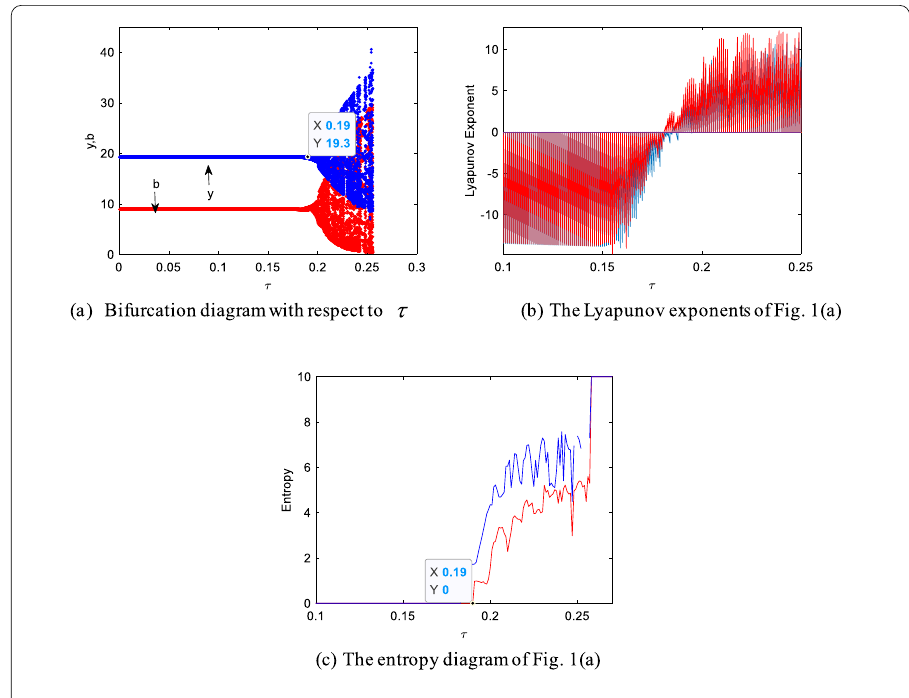
Figure 1 The impact of τ on the